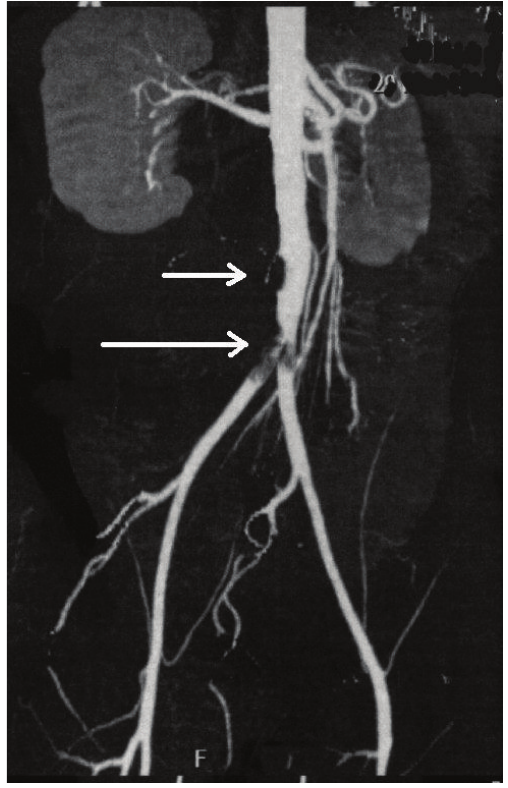
Figure 2: CT angiography of the lower limbs showing distal posterior and anterior tibial artery occlusion of the left side and three-vessel occlusion of the right